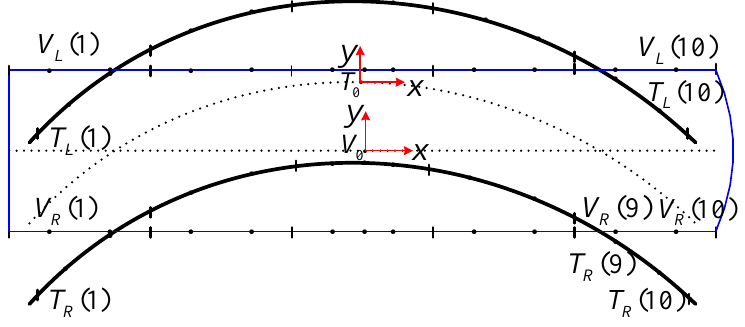
corresponding coordinate systems T R ( i ) on the right side of the track and the corresponding coordinate systems V R ( i ) are on the vehicle body; the origin of V R ( i ) is set on the i th motion chain on the right side of the vehicle body, and the direction of coordinate axis is consistent with V 0 . The track reference coordinate system T 0 and the vehicle reference coordinate system V 0 can be defined. The origin of V 0 is located on the central line of the vehicle body. The x-axis is along the central line of the vehicle body and points to the positive direction of the vehicle body. The z-axis is perpendicular to the vehicle body plane, and the positive direction is upward. The y-axis is perpendicular to the vehicle body central line. These coordinate systems are shown in Figure 6.